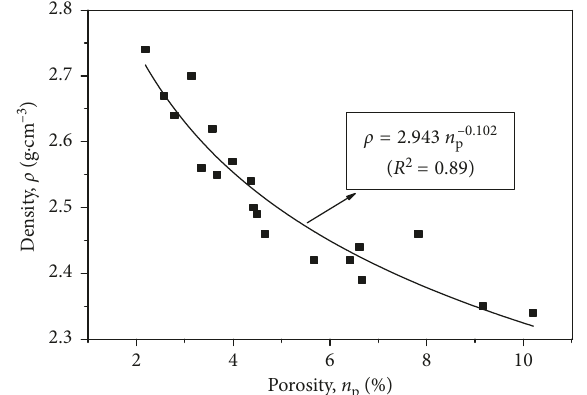
Figure 6: Relationship between porosity and density of weakly weathered